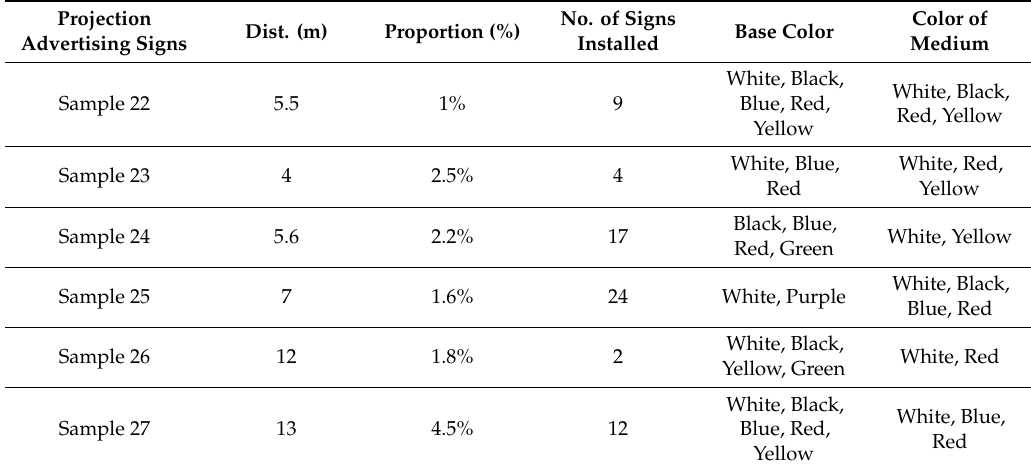
Table 3. Analysis of landscape samples of projection advertising